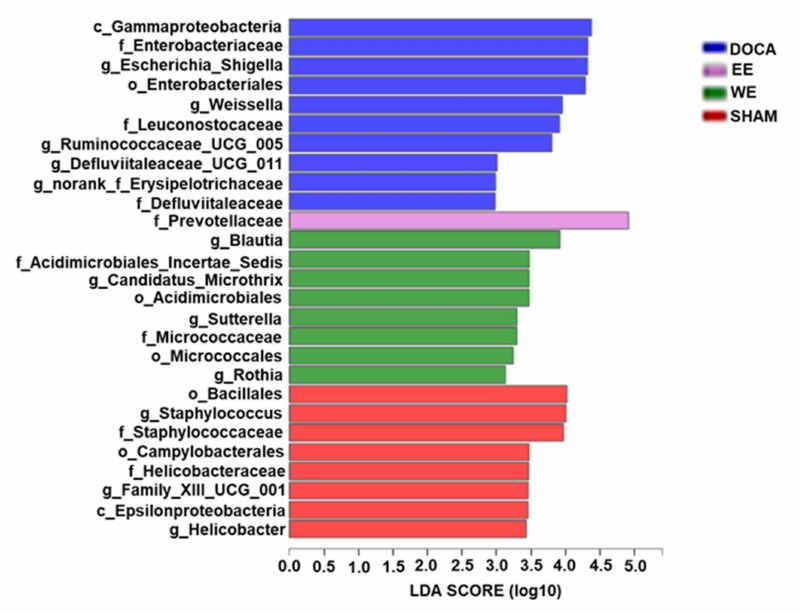
Figure 7. Phylogenetic distribution of gut microbiota of rats in SHAM, DOCA, WE and EE at week 14. Indicator bacteria with LDA scores of 2 or greater in bacterial